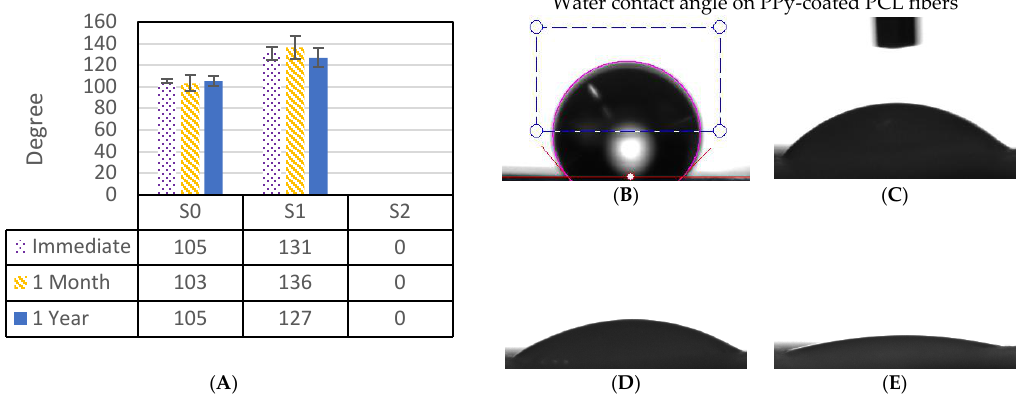
Figure 3. A. Water contact angle on pure PCL fibers (S0) and on coated samples. Image B shows the water contact angle of PPy-coated PCL without plasma treatment (S1) after it stabilized (~1 s), while images ( C – E ) shows the change of a water drop for the plasma-treated sample (S2) over time in a timeframe of 0.01, 0.03 and 0.05 s. The water contact angle for plasma-treated samples reached 0° in less than 0.1 s. ( A ) Water contact angle in degrees; ( B ) No plasma treatment, S1; ( C ) Plasma treated, S2: 0.01 s; ( D ) Plasma treated, S2: 0.03 s; ( E ) Plasma treated, S2: 0.05 s.